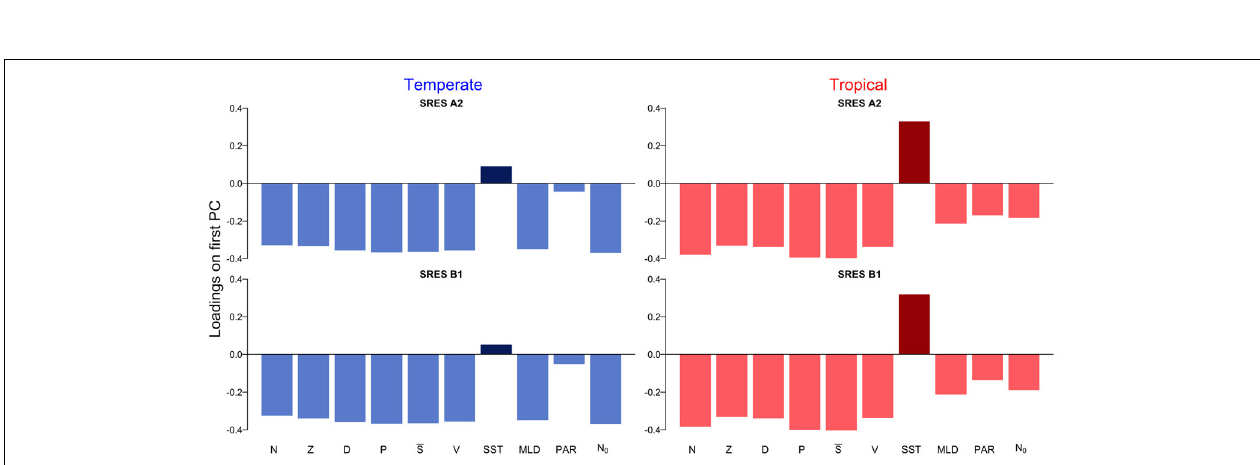
FIGURE 3 | Scores on the first principal component for temperate and tropical regions under the SRES A2 and SRES B1 emission scenarios.